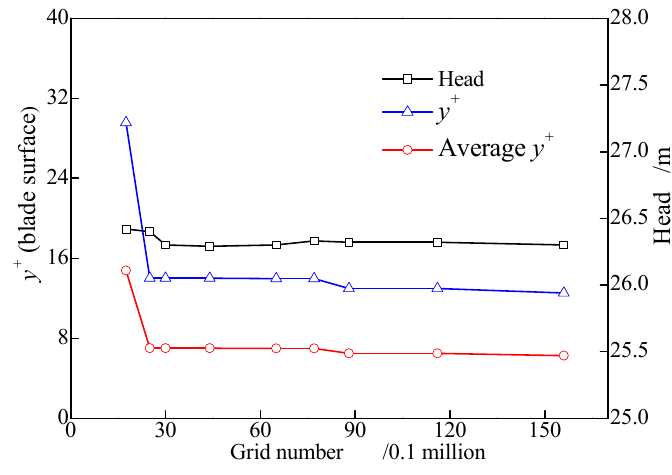
Figure 4. Mesh independence validation.